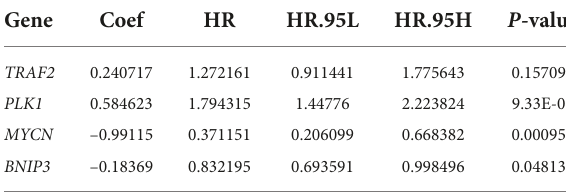
TABLE 1 Multivariate Cox regression analysis of prognostic necroptosis-related genes